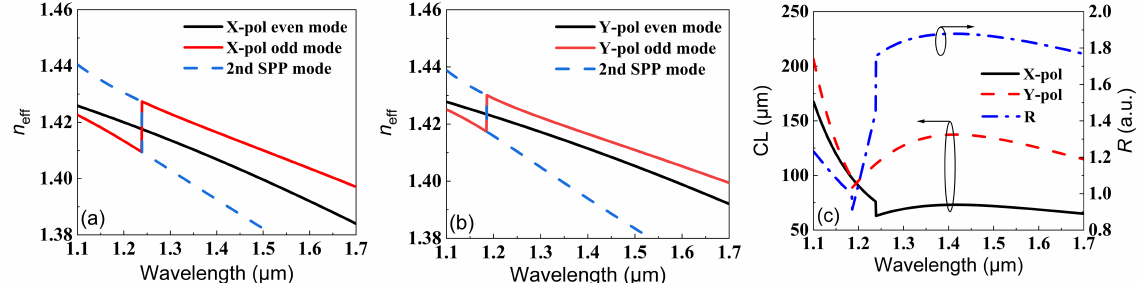
Figure 3. The effective refractive indexes of ( a ) the X-pol and ( b ) Y-pol modes. ( c ) The variations in CLX , CLY , and R with